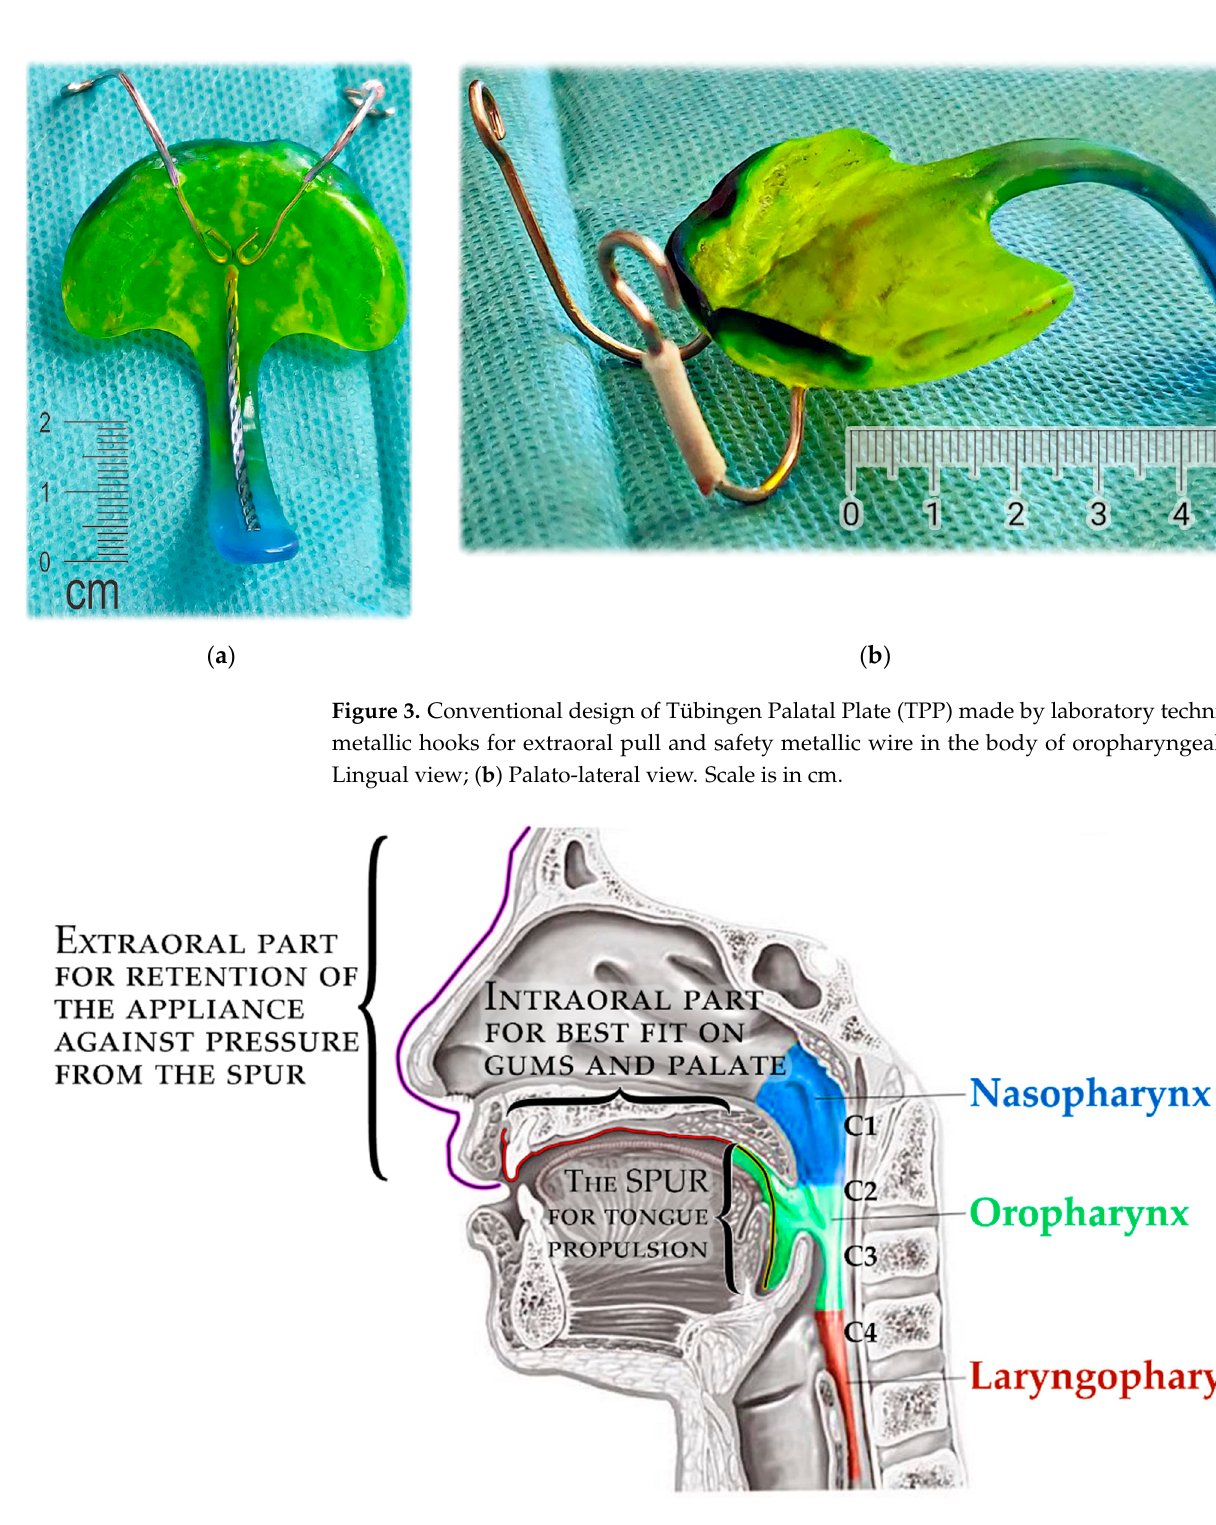
Figure 4. The complex scheme of processes covered by this paper. Only the parts in contact with the appliance were relevant from the CT and were exported in STL format and later aligned with the STL output from the intraoral scanning, as is shown in Figure 5a,b.